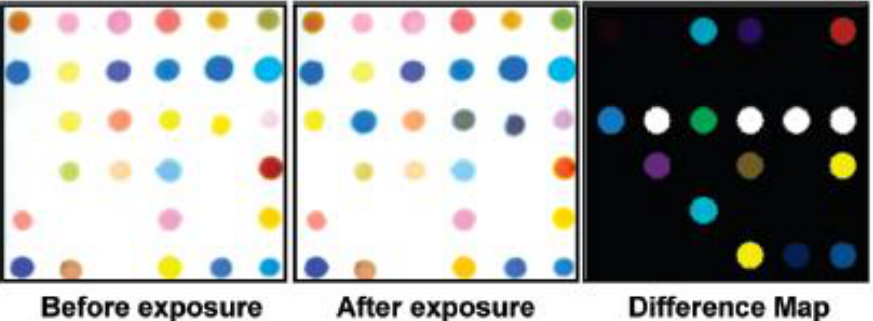
Figure 13. Images of the colorimetric array before exposure, after 2 min of exposure to ammonia at its IDLH (immediately dangerous to life or health) concentration (300 ppm) at 298 K and 50% relative humidity and the generated color difference map [54].